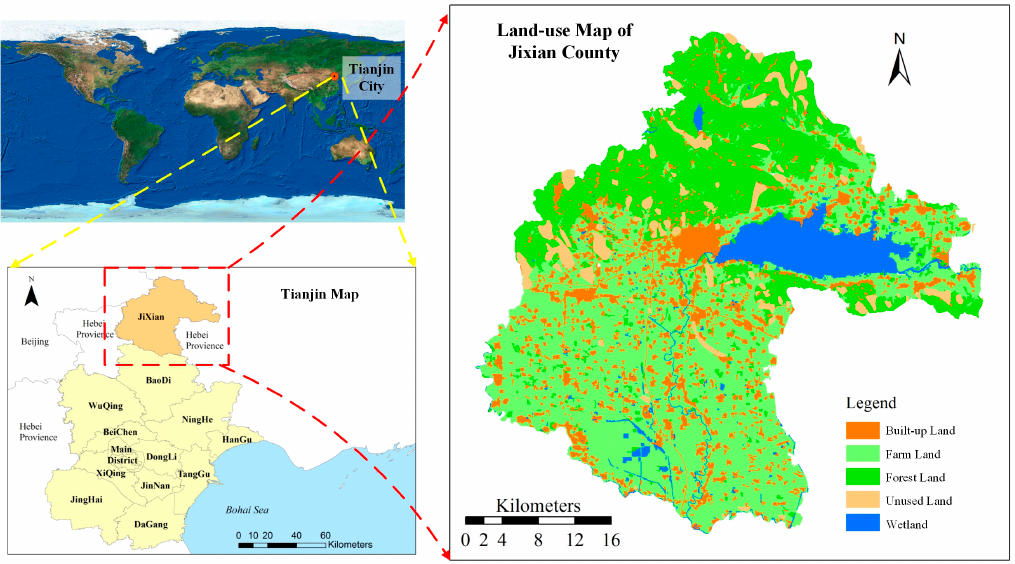
Figure 9. The location and land-use map of Jixian (the land-use data are adapted from [33]).